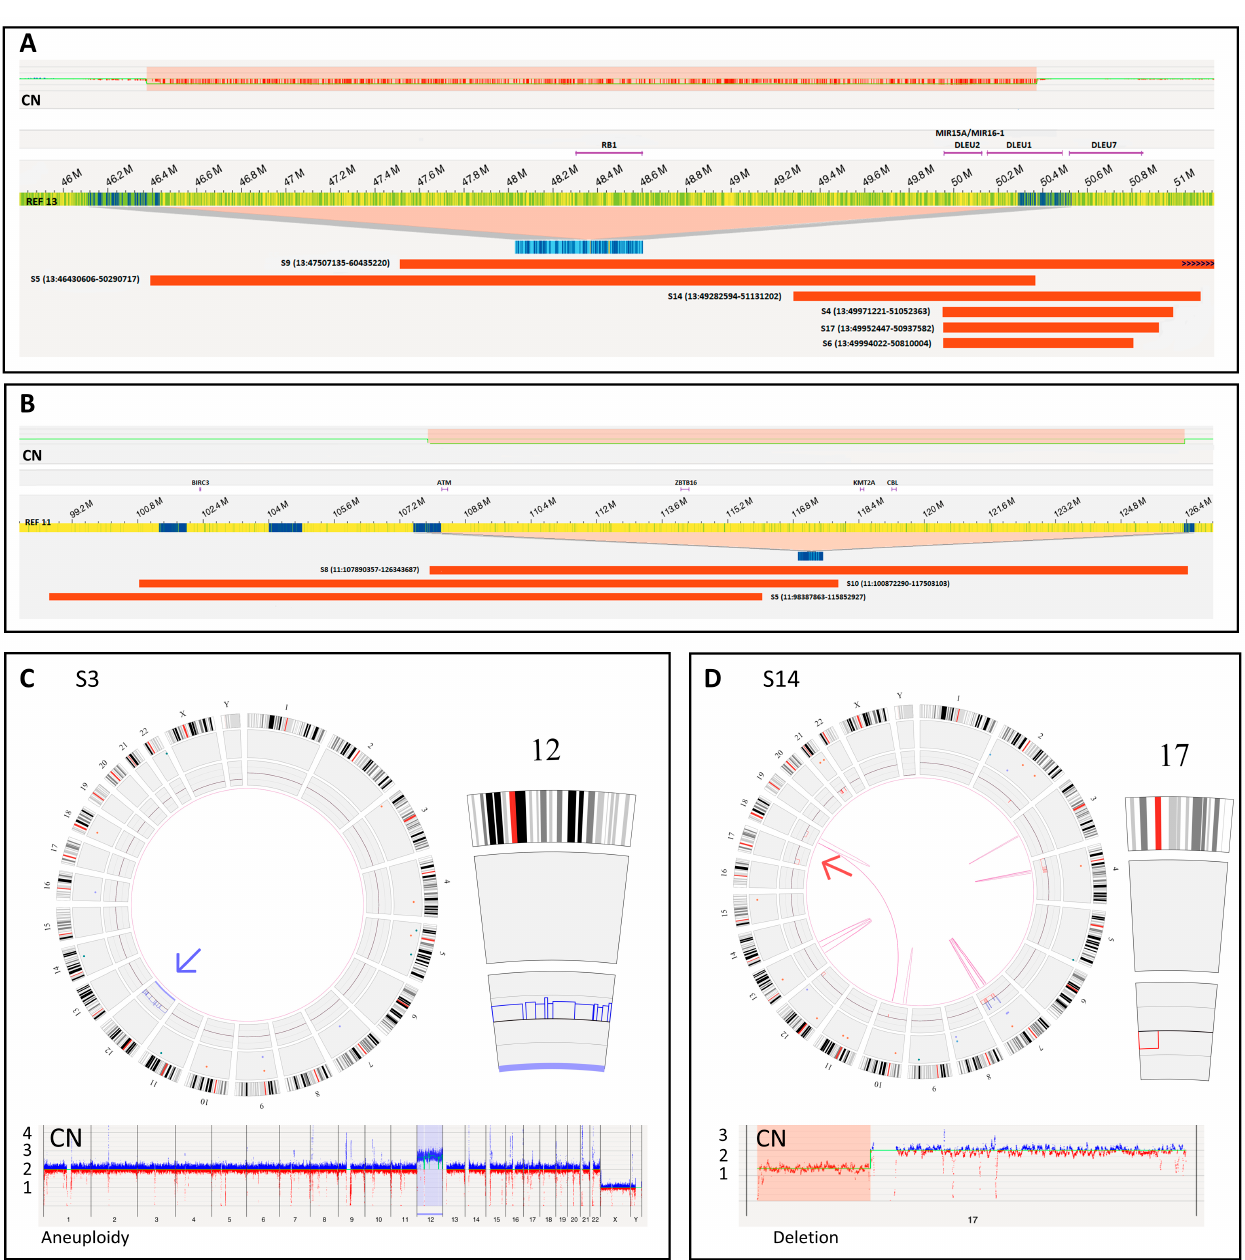
Figure 1. Visualization of aberrations detected by OGM in SOC FISH-targeted loci. ( A ) Genome map view showing the sizes and locations of the six different 13q14.3 ( DLEU region) deletions, of which two also encompassed the RB1 tumor suppressor gene. ( B ) Genome map view of the three different 11q22.3 ( ATM ) region deletions also involving other leukemia genes. ( C ) Circos plot view and copy number (CN) profile view of a sample with trisomy 12. ( D ) Circos plot view and CN profile of a sample with a deletion of the short arm of chromosome 17 ( TP53 deletion). Table 1. OGM results compared to SOC FISH results.